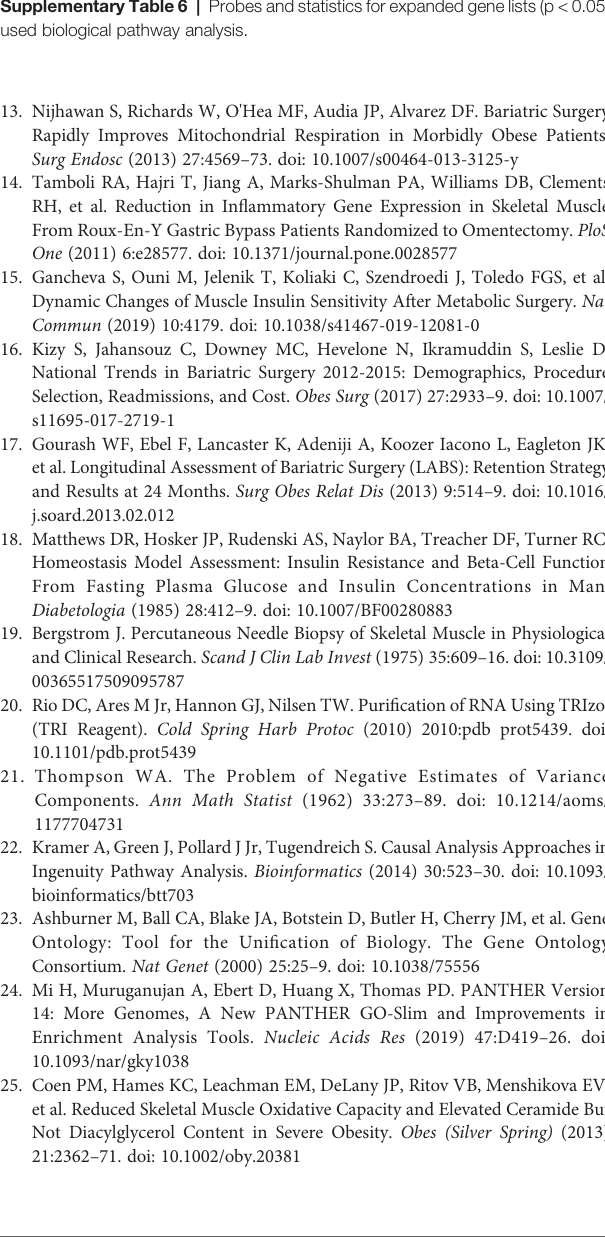
Supplementary Table 5 | Probes and statistics for Pre-to-Post surgery skeletal muscle gene expression